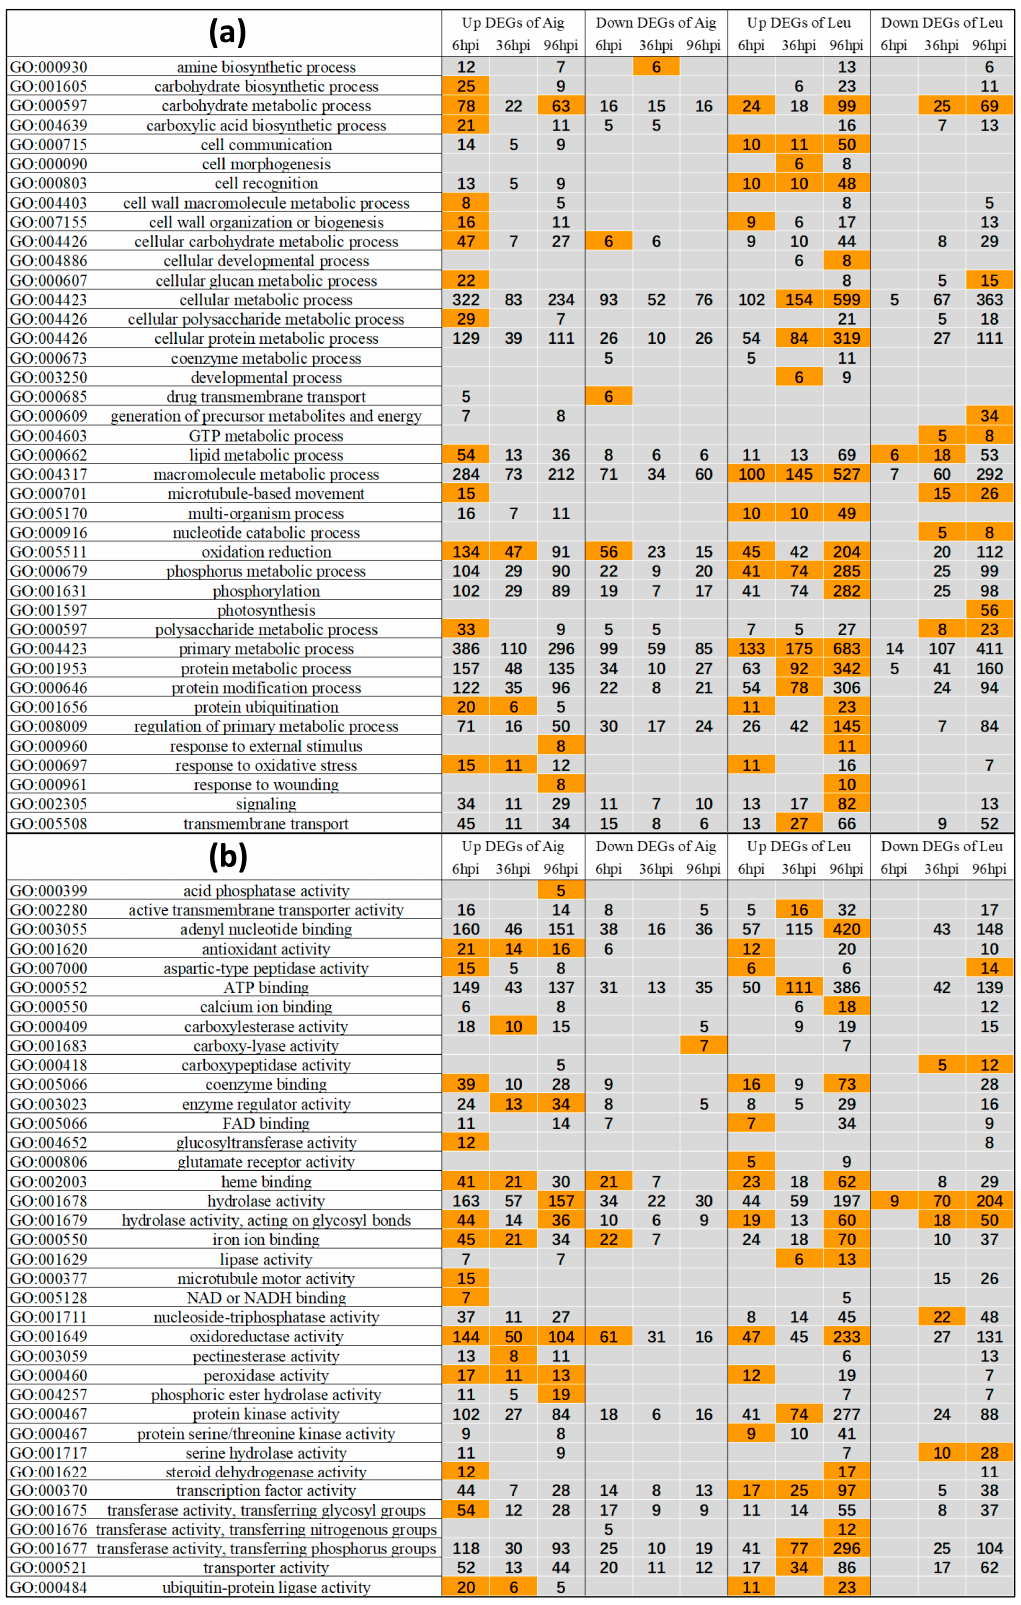
Figure 4. GO enrichment of up or down DEGs of two poplar sections in three infection stages. ( a ) Processes. ( b ) Functions. The GO enrichment was completed under a significance threshold of 0.05 following Hochberg false discovery rate (FDR) correction. The numbers in the diagram indicates the gene number belong to corresponding GO terms. Enriched GO terms were marked by